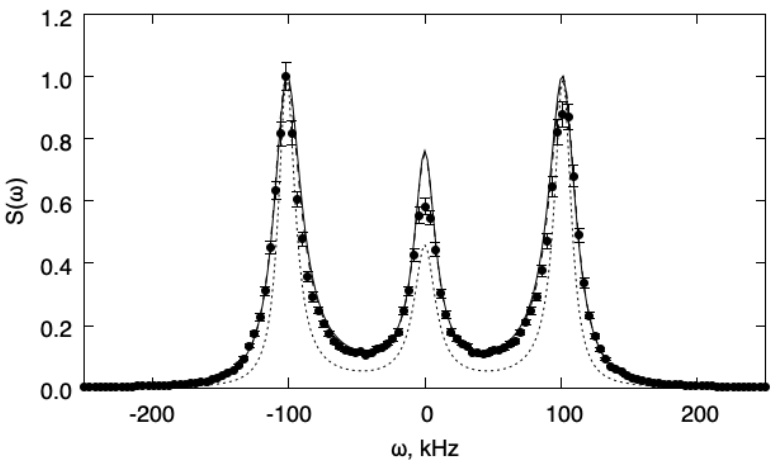
Figure 2. Fluctuation power spectra for the fast relaxation case ( p 0 = 0.1). The spectra are normalized to unit maximum value. Full line: 1T model; dotted line: 1T model without bulk viscosity; dashed line: 2T model; symbols: